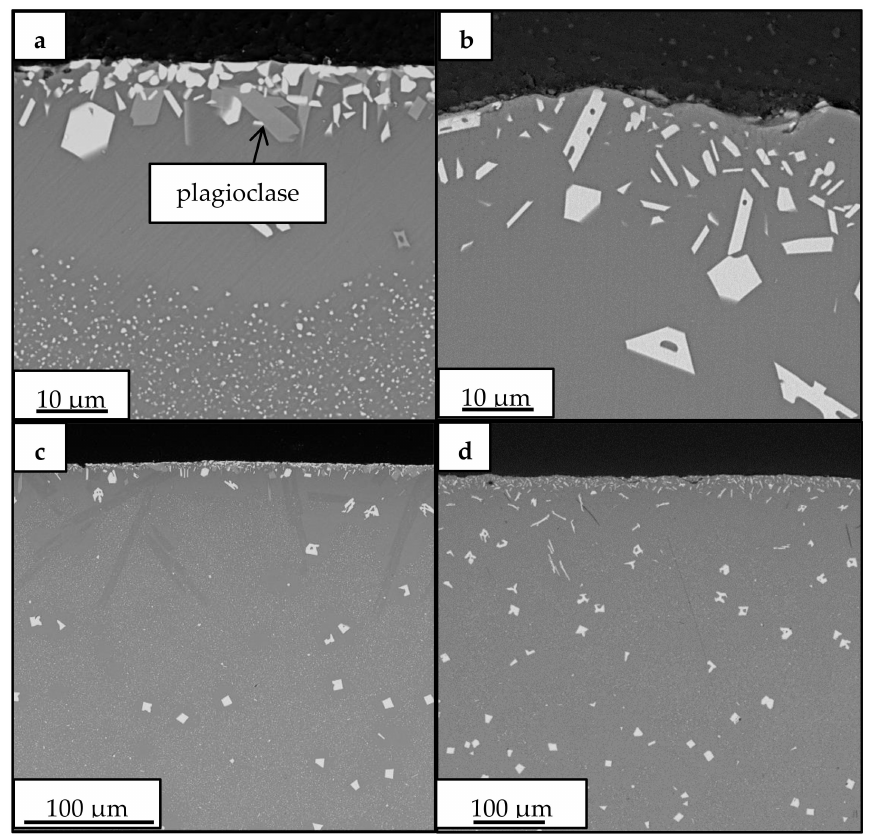
Figure 6. Cross-section BSE images for bulk volcanic ash glass samples treated at 1100 ( a , c ) and 1150 ◦ C ( b , d ) for 10